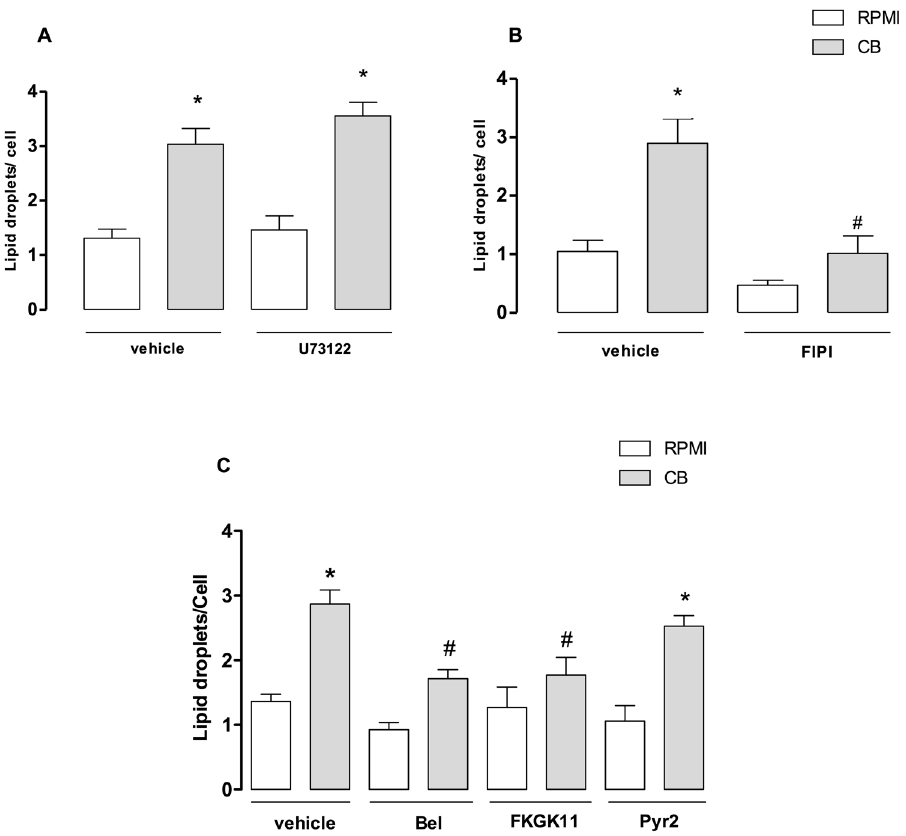
Figure 5. PLD and iPLA 2 , but not PLC and cPLA 2 are required for CB-induced LD formation. Peritoneal macrophages were incubated with the inhibitors U73122-1 µ M ( A ), FIPI-1 µ M ( B ), BEL-2 µ M, FKGK11- 1 µ M or Pyr-2-1 µ M ( C ) for 30 min and then with CB (0.4 µ M) for 3 h. LDs were quantified using light microscopy after osmium staining. Each bar represents the mean ± SEM of LDs/cell in 50 cells. Values represent means ± SEM for 3–5 animals. * p < 0.05 compared with RPMI/vehicle-stimulated cells; # p < 0.05 compared with vehicle treated/CB-stimulated